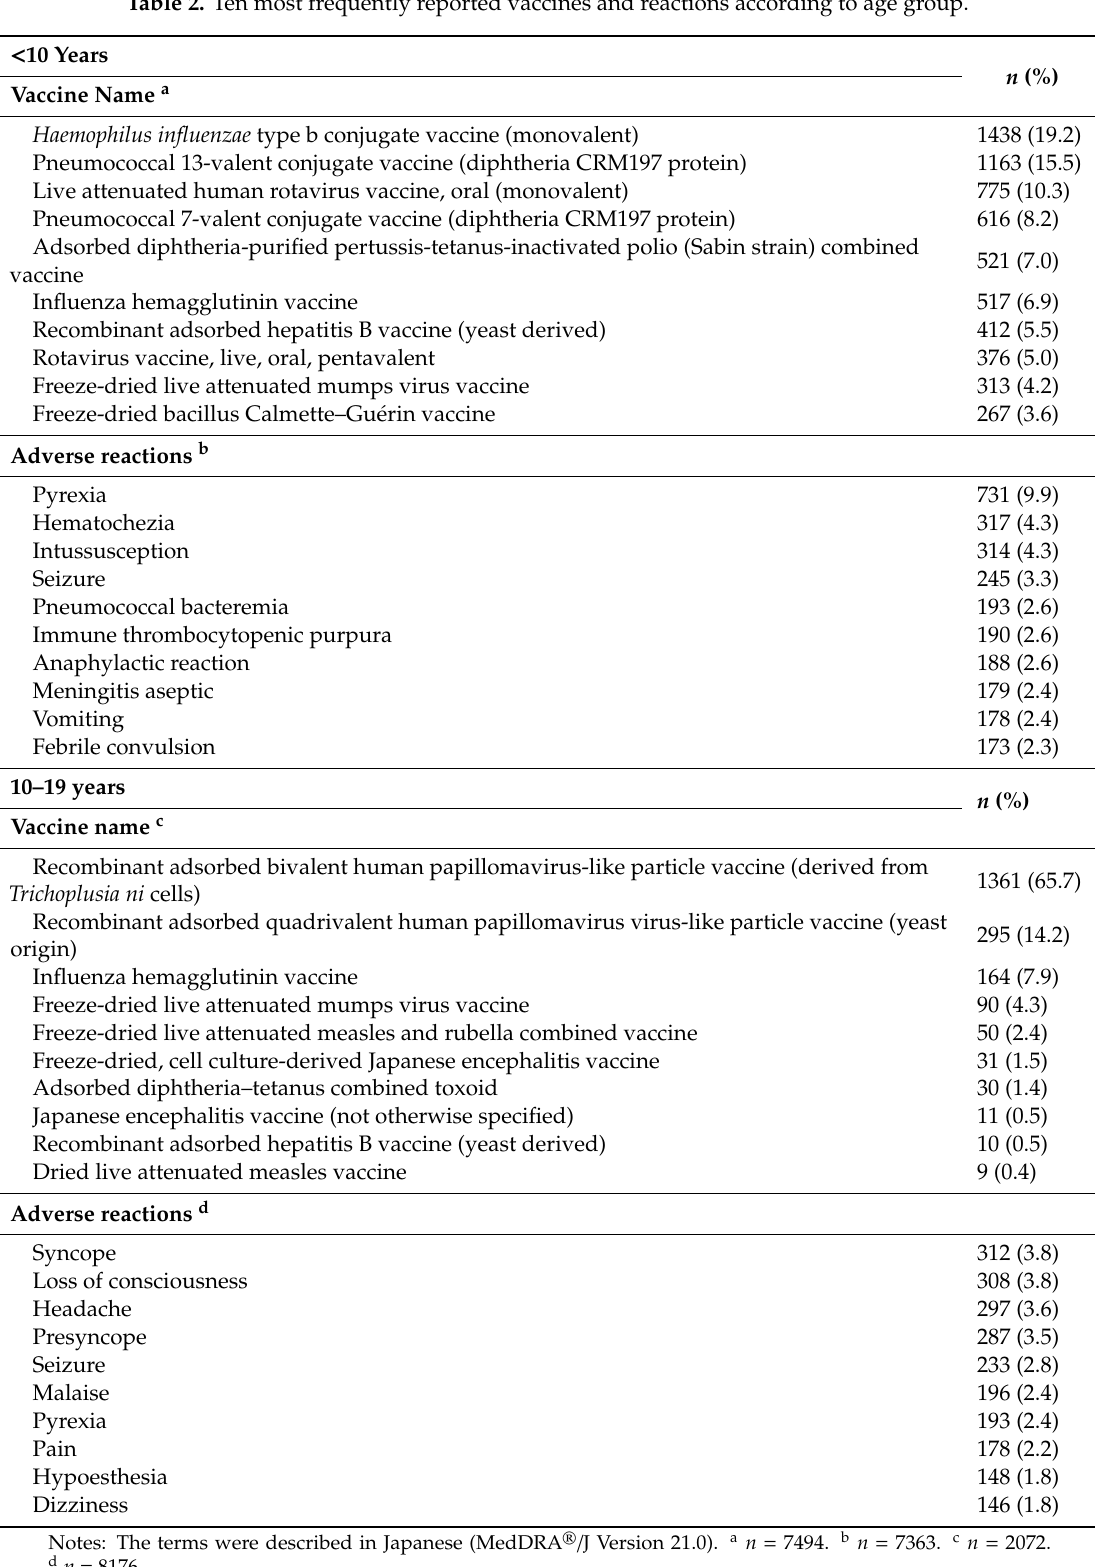
Table 2. Ten most frequently reported vaccines and reactions according to age